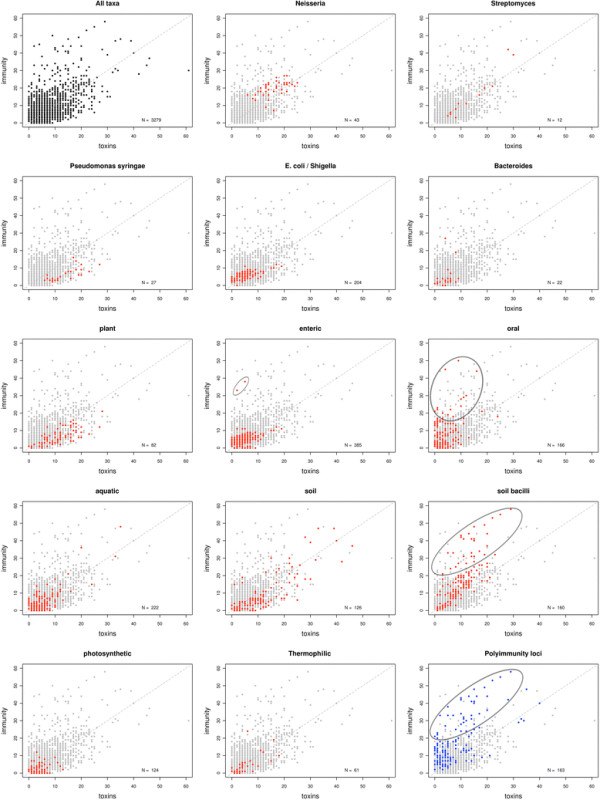
Scatterplots of the number of toxins versus number of immunity proteins per genome. In scatter plots, black or gray dots in the background represent all taxa, and red or blue dots correspond to taxa belonging to the clade or ecological properties described on each plot’s title. The dashed line corresponds to the diagonal (x = y) and the ellipses encircle taxa that are characterized by an excess of immunity proteins as discussed in the text.